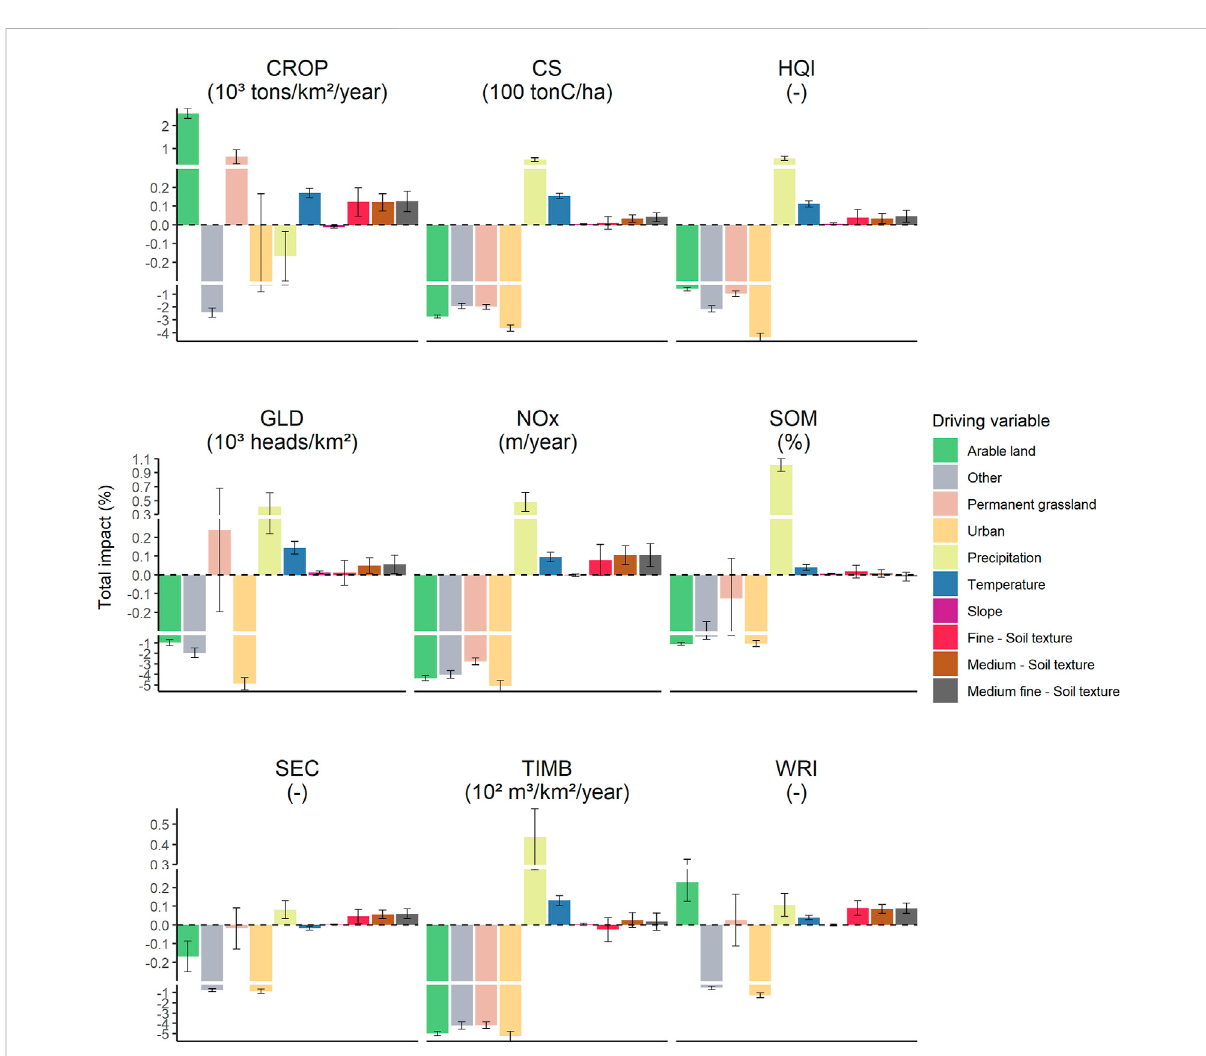
FIGURE 3 Total impacts of driving variables on ecosystem services with the spatial Durbin error model (SDEM). The total impact is the sum of direct and indirectimpacts,andit correspondsto therelativevariation (in %)oftheecosystemservice inquestion whenincreasingthelanduseareapercentage (to the detriment of forest), the percentage of the soil texture area (to the detriment of the coarse soil texture), or the other biophysical variables by 1%. When the error bar (95% con fi dence interval of a normal distribution calculated from the estimated parameters and their standard deviations) overlaps the horizontal zero line, the impact of a driving variable on the ecosystem service is not statistically signi fi cant. CROP stands for cropproduction;CSforcarbonstorage;HQIforhabitatqualityindex;GLDforgrazinglivestockdensity;NOXfordepositionvelocityofnitrousoxide; SOM for topsoil organic matter concentration; SEC for soil erosion control; TIMB for timber removal; WRI for water retention